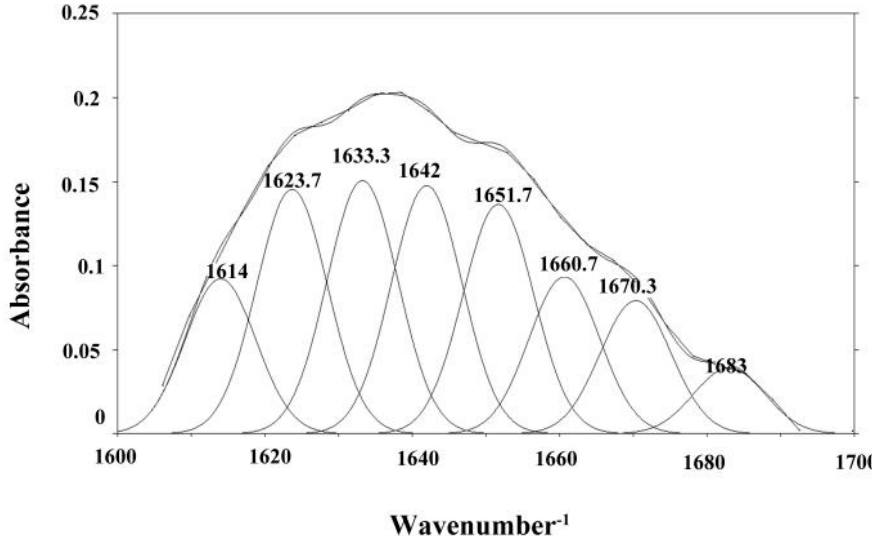
Figure 6. Fitting FTIR chart for OVA from the top phase of the ATPS.